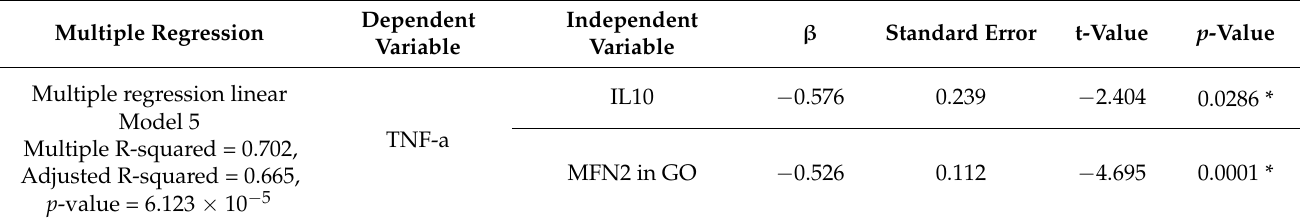
Table 5. Multiple regression analysis models of the relationship between TNF-a level and Il-10 level and MFN2 gene expression in